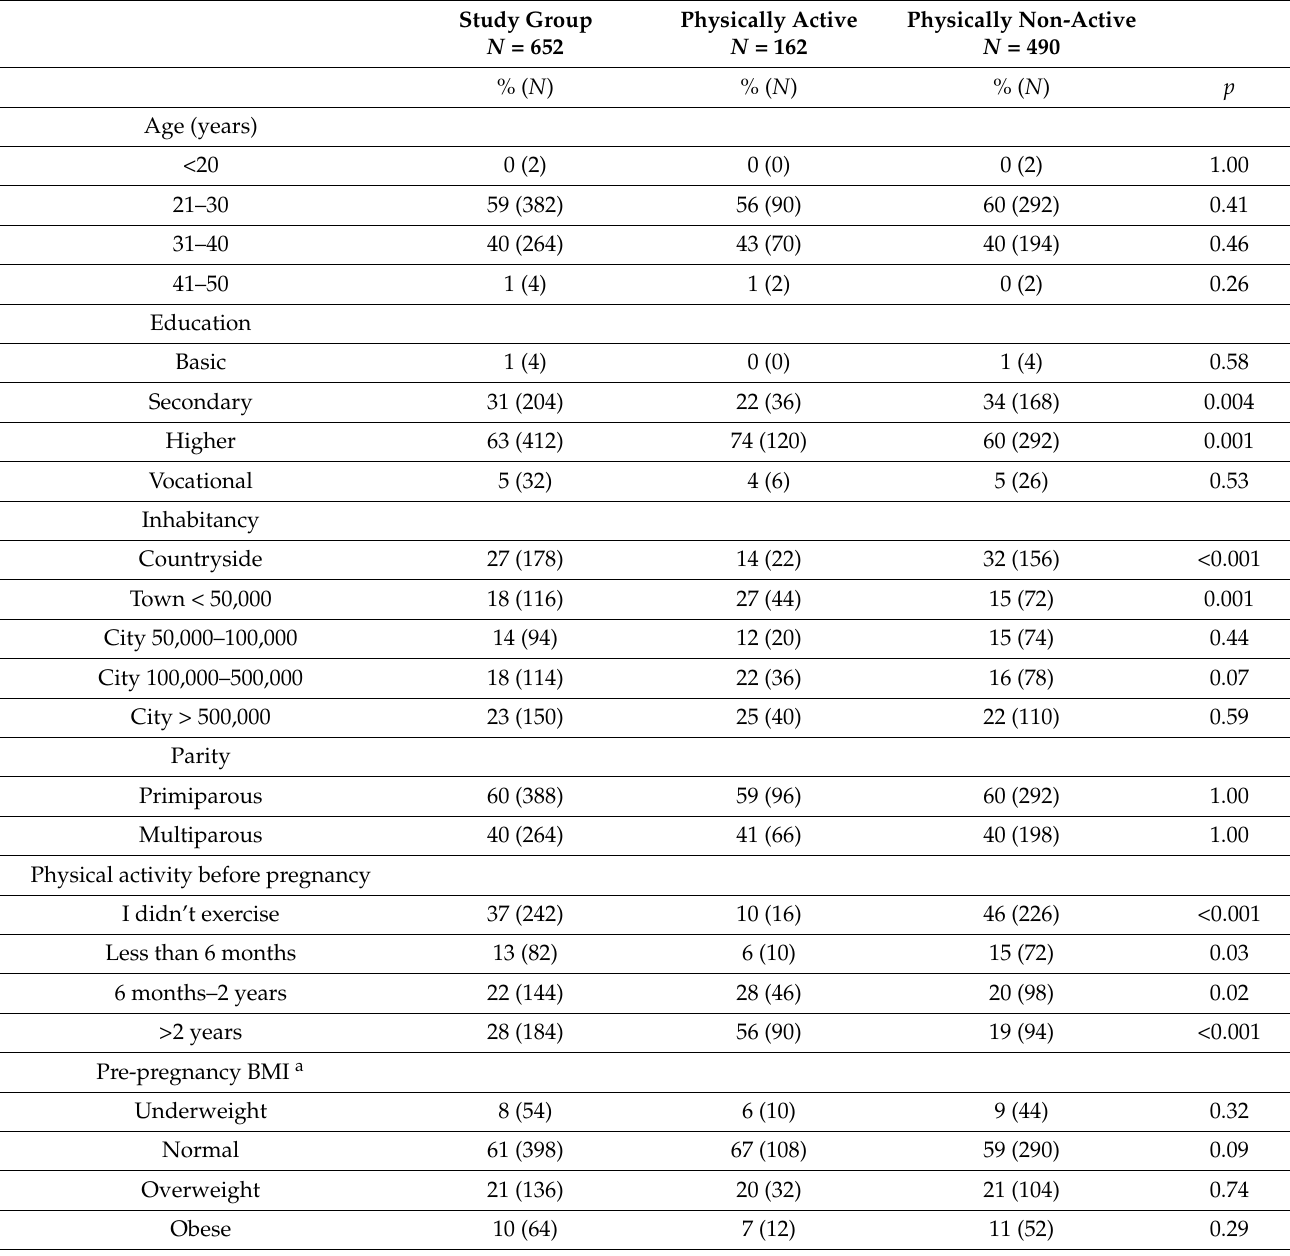
Table 1. Characteristics of the study